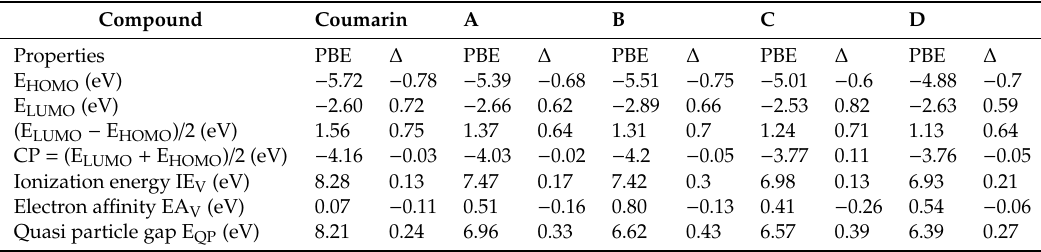
Table 3. Electronic properties of the Coumarin and derived compounds A , B , C and D , employing PBE XC in combination with basis set 6-31G*, and di ff erence between two functionals ( ∆ = B3LYP–PBE). Compound